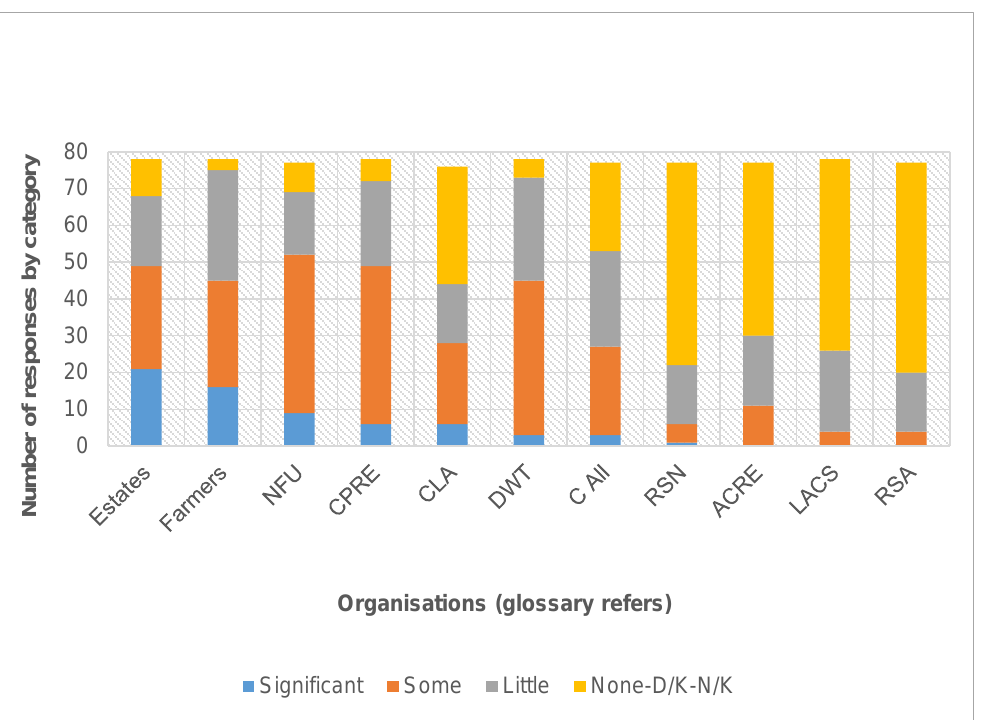
Figure 7: Participants’ assessments of the loci of influence over rural policy in West Dorset ‘rural’